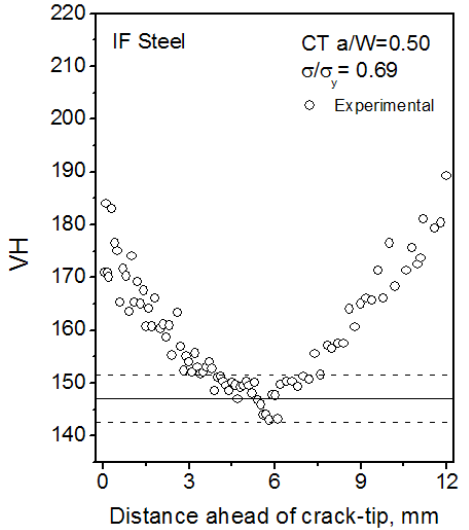
Figure 4: Typical variation of microhardness along the entire ligament of a CT specimen.